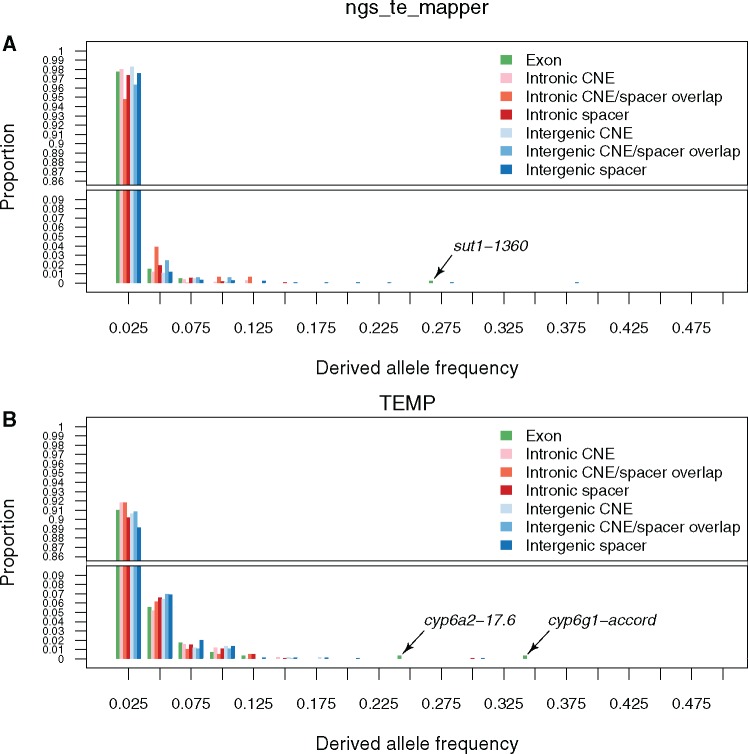
—The derived allele frequency (DAF) spectrum for TE insertions is similar across different compartments of the Drosophila melanogaster genome. DAF spectra are shown for TE insertions predicted by ngs_te_mapper (A) or TEMP (B). Allele frequency classes are shown on the X axis, and the proportion of TE insertions observed in a particular compartment of the genome at that allele frequency is shown on the Y axis. Note that the Y axis is split to allow better visualization of the proportion of higher allele frequency classes.